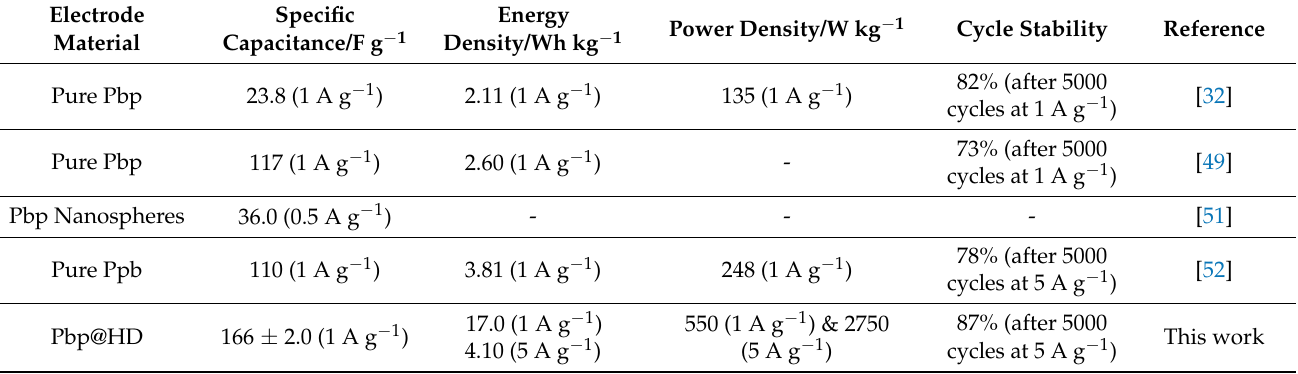
Table 2. Comparison of electrochemical performance of conjugated Pbp for symmetric two-electrode supercapacitor in 1 M H 2 SO 4